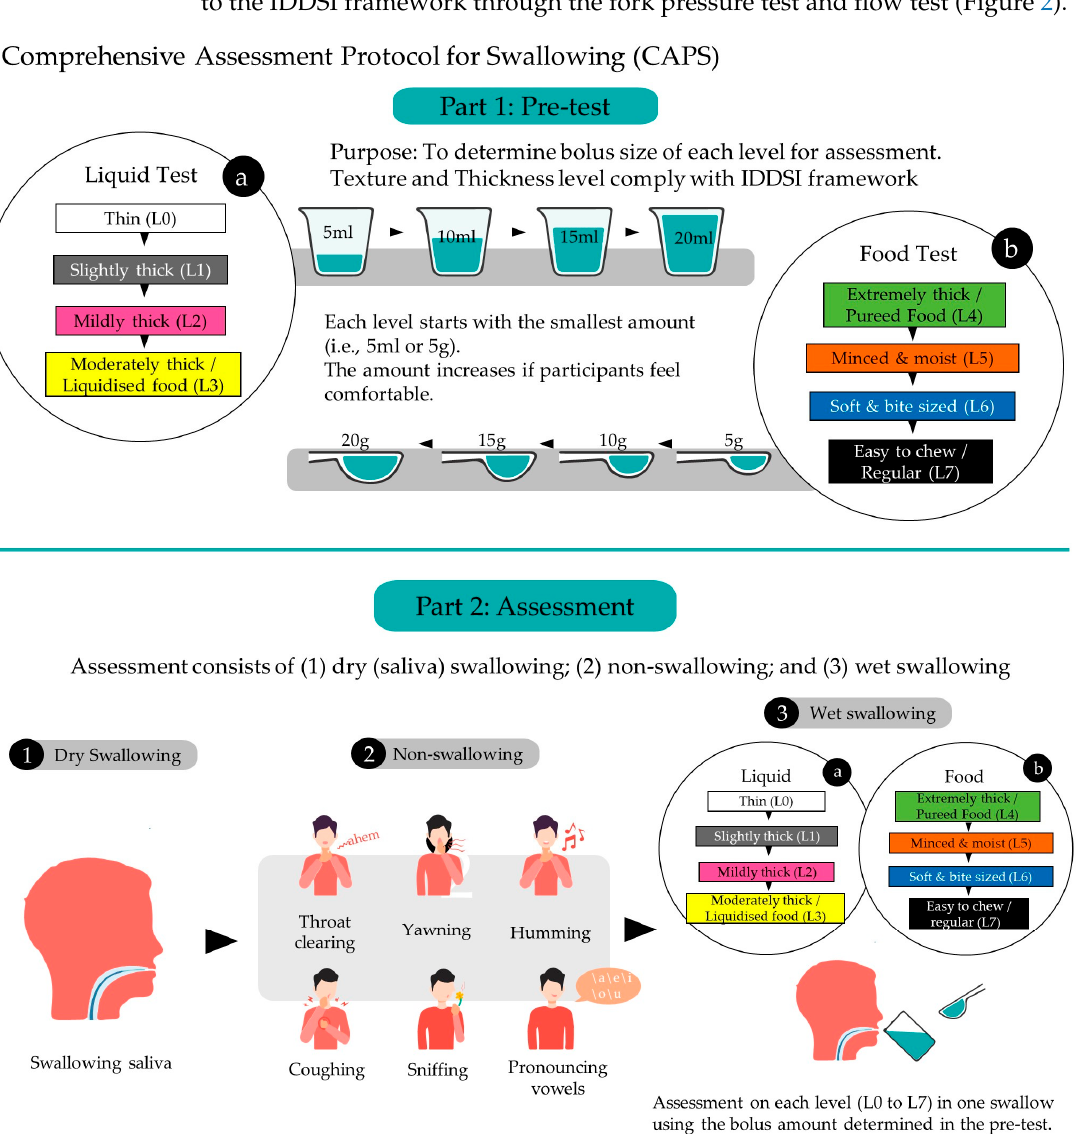
Figure 1. Overall framework and sequence of the Comprehensive Assessment Protocol for Swallowing (CAPS).